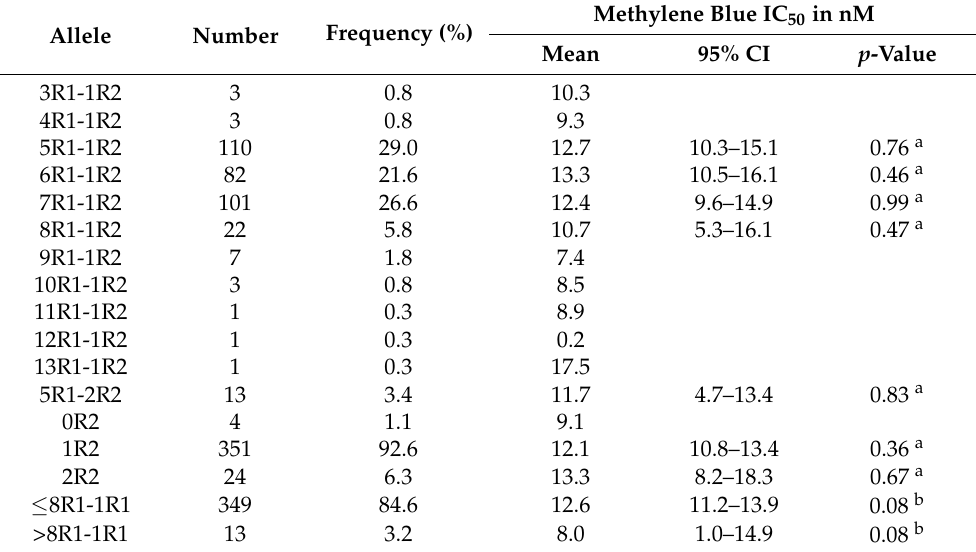
Table 3. Association between the Pfmdr5 genotypes analyzed among 379 clinical P. falciparum African isolates and ex vivo susceptibility to methylene blue.